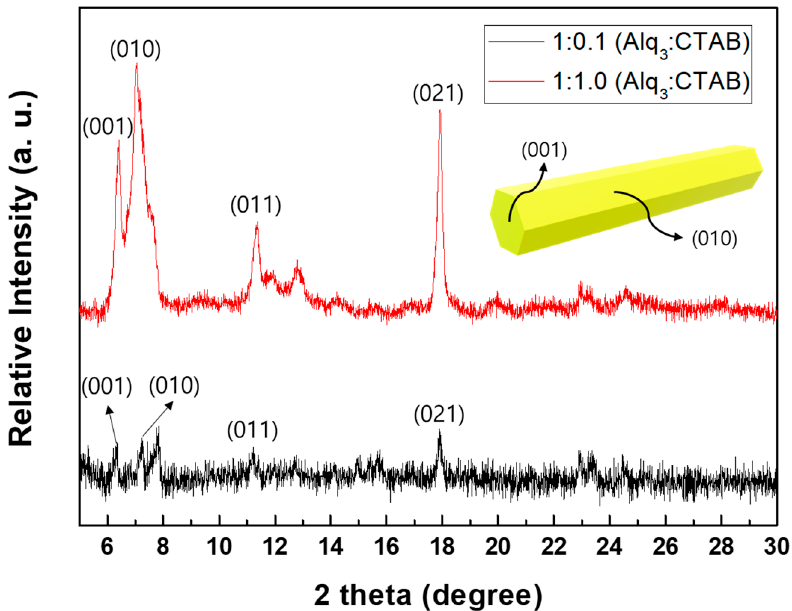
Figure 3. XRD spectra of crystals whose molar ratio with Alq 3 and CTAB were 1:0.1 (top, red line) and 1:1.0 (bottom, black line). (inset: schematic illustration of crystal with lattice plane).